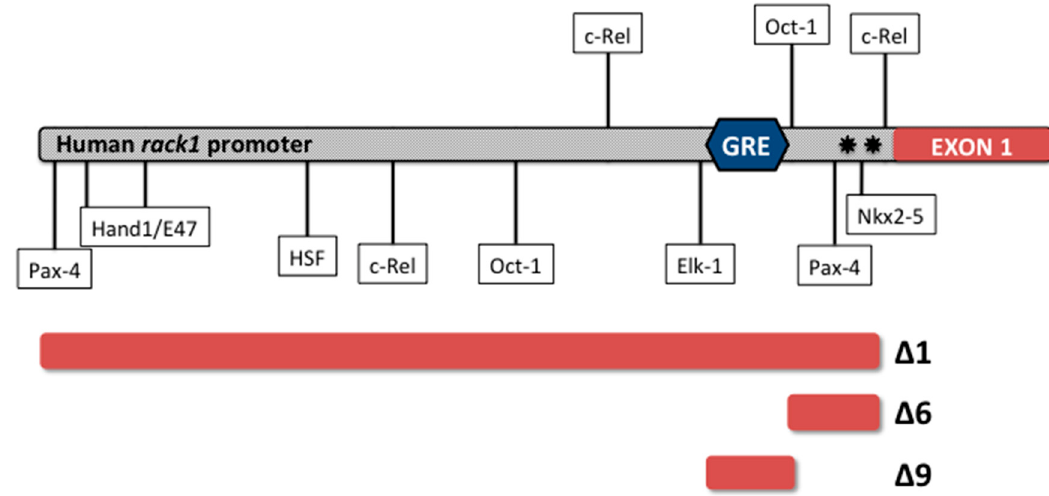
Figure 1. Structural analysis of the human receptor for activated C kinase 1 (RACK1) gene promoter region. Bioinformatic analysis of the 5 (cid:48) -flanking region within 7 kb upstream of the putative promoter region of the human rack1 gene identified two major transcription sites, which are indicated with stars just before the beginning of Exon 1. Several putative cis-acting elements are shown; in particular, the putative unique GRE (Glucocorticoid Responsive Element) is detected at the nucleotidic position -186 with the sequence AGAACACCCTCCGGAAGCACA. Functional characterization of the GRE site was performed with deletion constructs ( ∆ 1, ∆ 6, and ∆ 9), including or excluding the GRE site. More details can be found in the text and in